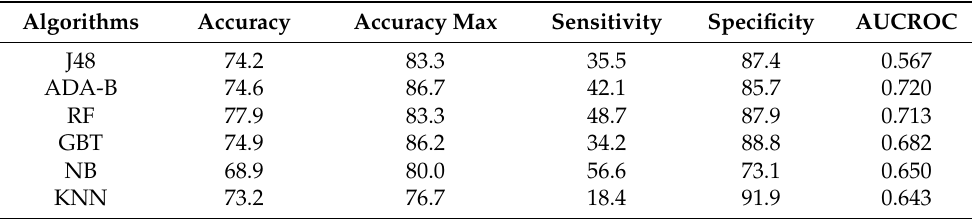
Table 2. Evaluation metrics (%) of the models computed on all 60 features with the 10-fold cross-